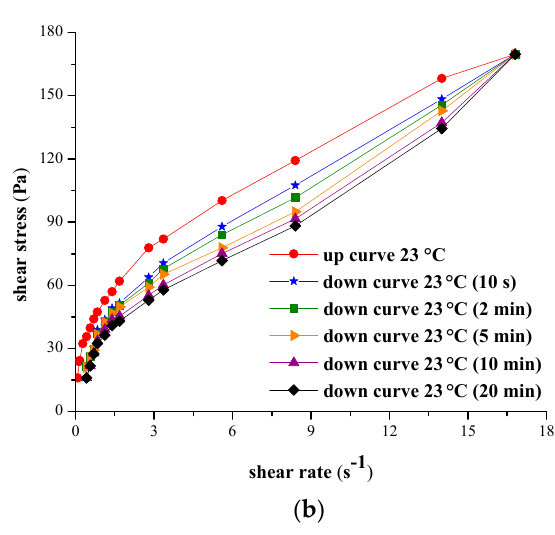
Figure 6. ( a ) Forward and backward (10 s) rheograms for hydrogel H2 tested at 23 °C and 37 °C; ( b ) forward and backward rheograms for hydrogel H8 tested at 23 °C (10 s, 2 min, 5 min, 10 min, 20 min).